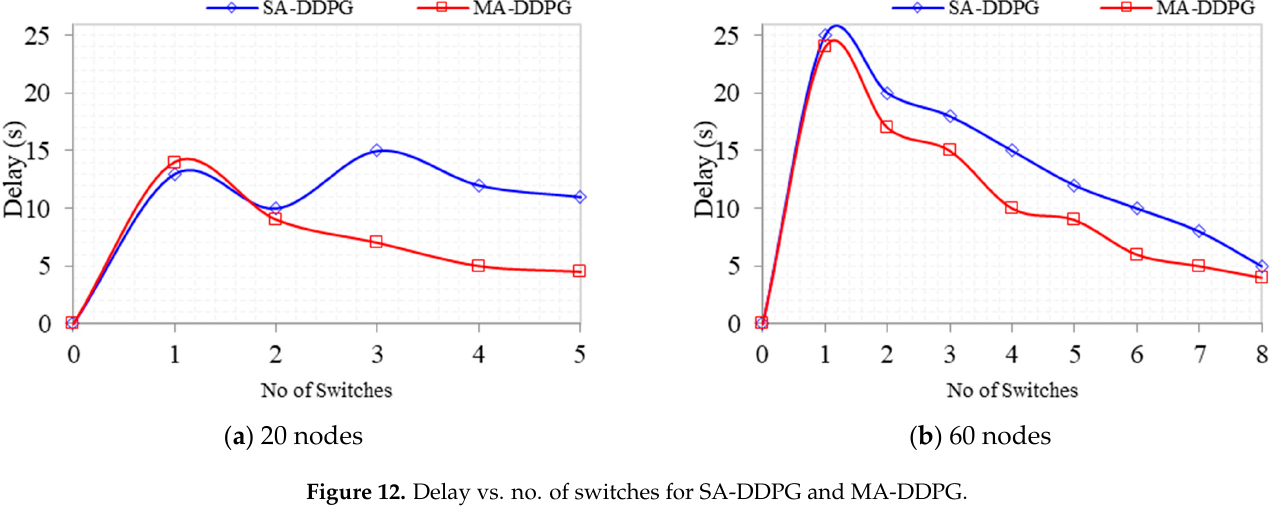
Figure 11. Jitter vs. no. of hosts for SA ‐ DDPG and MA ‐ DDPG.